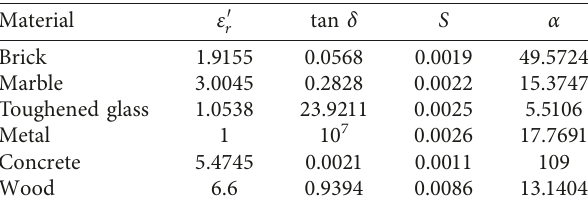
Figure 9: Deployment of the Tx and